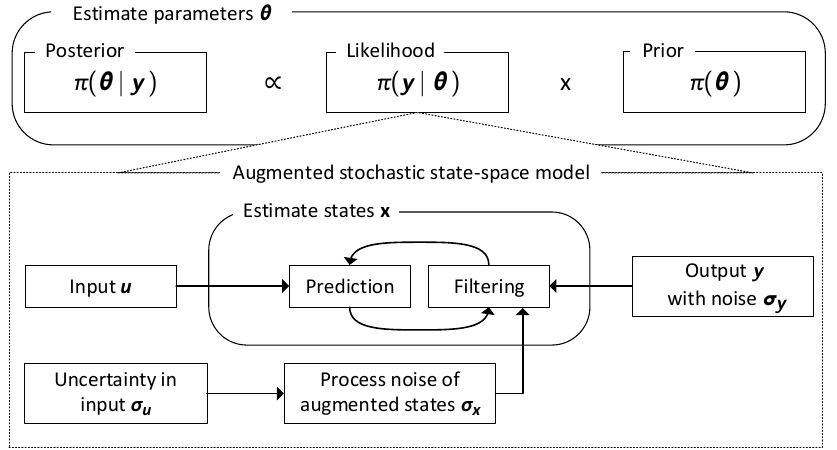
Figure 2. Bayesian calibration using an augmented stochastic state-space model to compute the